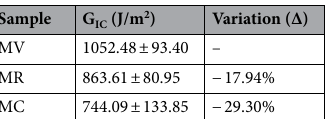
Table 4. Summary of the results of the DCB